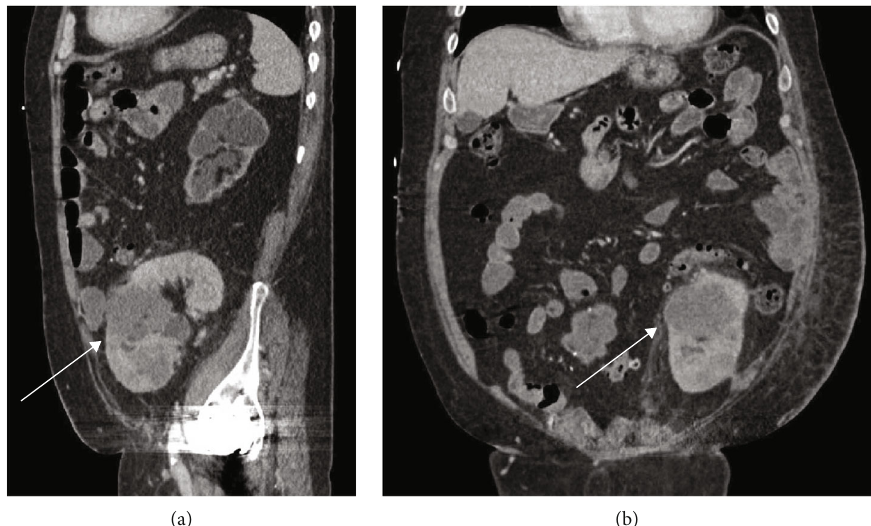
Figure 5: (a) For case 2, sagittal view of computer tomographic scan with intravenous contrast visualized 6.6cm mass in the renal allograft (arrow). (b) Same mass (arrow) showed in coronal view of the same scan.